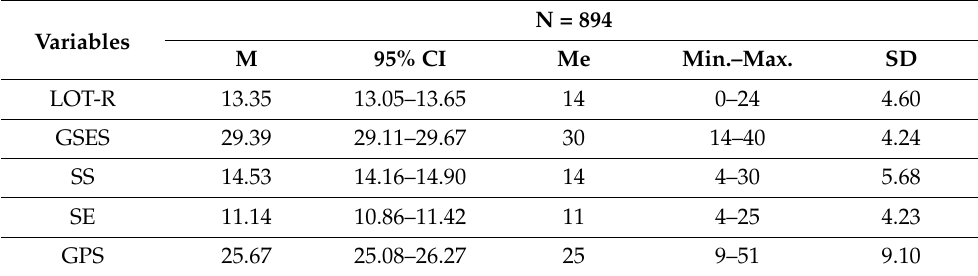
Table 2. Descriptive statistics of the variables under analysis.